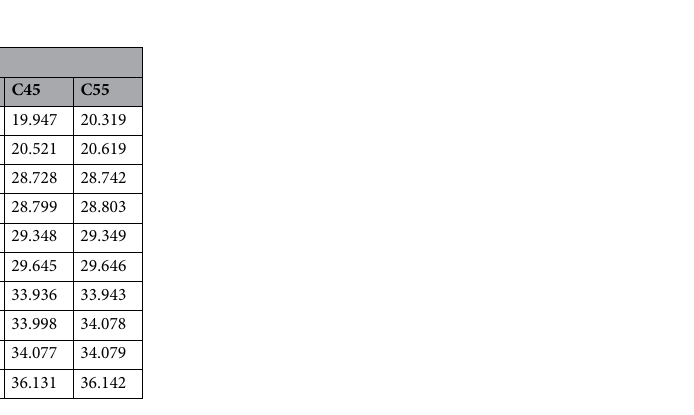
Table 3. The first ten order natural frequencies of the ball mill system under different concrete